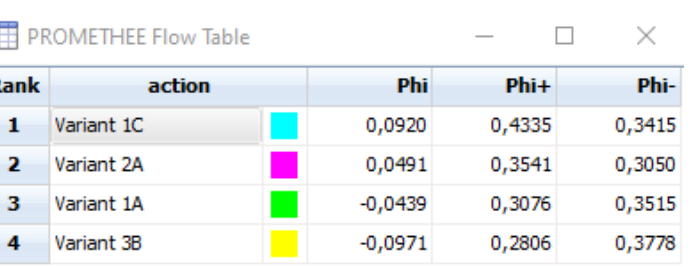
Figure 4. An overview of the result of Scenario 1 of the multi-criteria analysis of the evaluation of the Rijeka-Zagreb railroad route section.